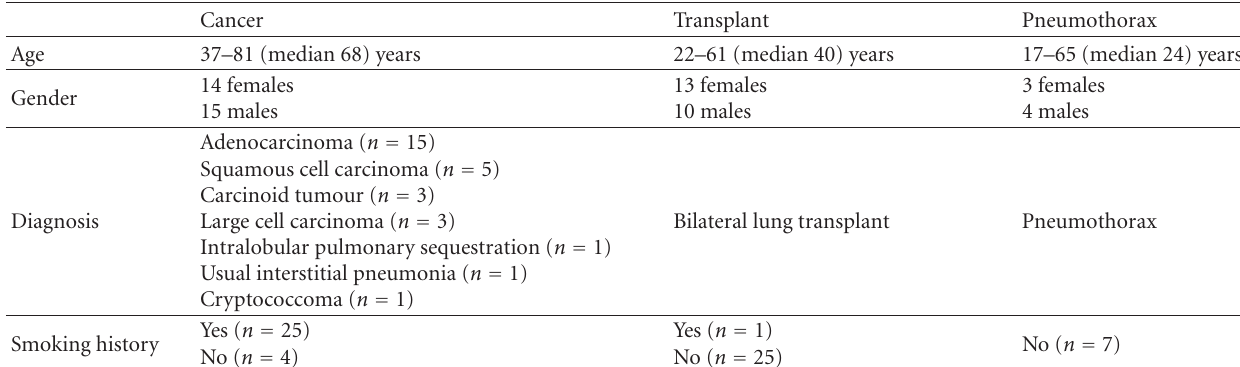
Table 2: Patient